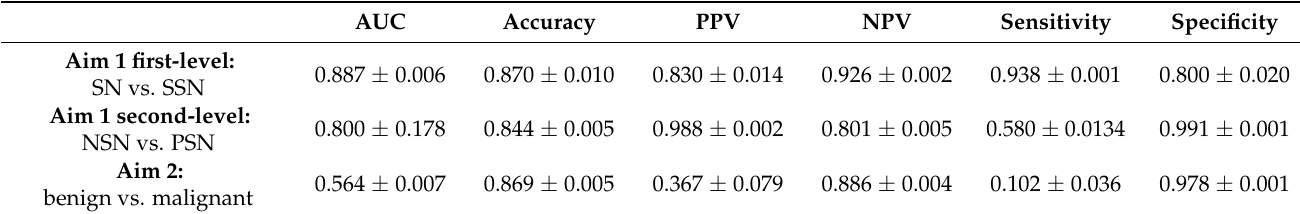
Table 2. Performance achieved by the radiomic classifiers fitted (nested 5-fold CV) on the blinded test set for Aim 1 (PN characterization) and Aim 2 (PN risk). Metrics are expressed as average ± standard